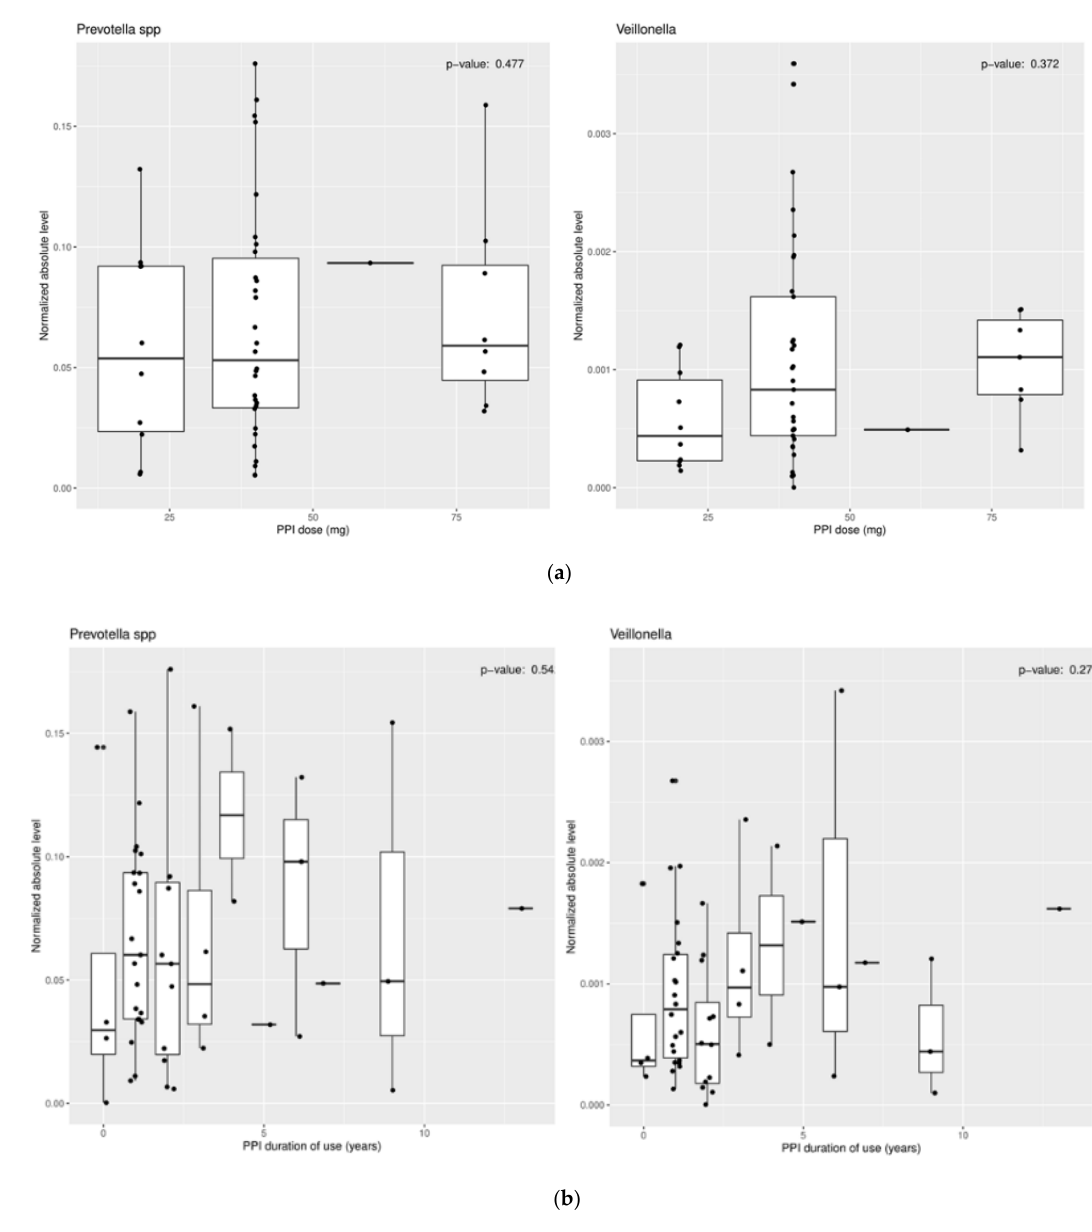
Figure 1. Relationship of ( a ) PPI dose and ( b ) PPI duration of use vs. normalized absolute levels of organism for Prevotella and Veillonella. There was no association between PPI dose or duration of use and organism level.